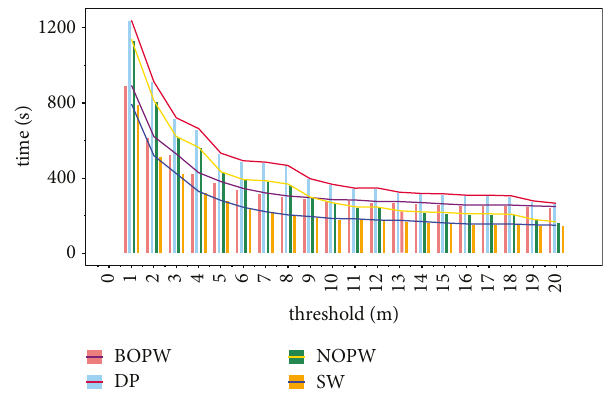
Figure 6: Compression time comparison of different algorithms.